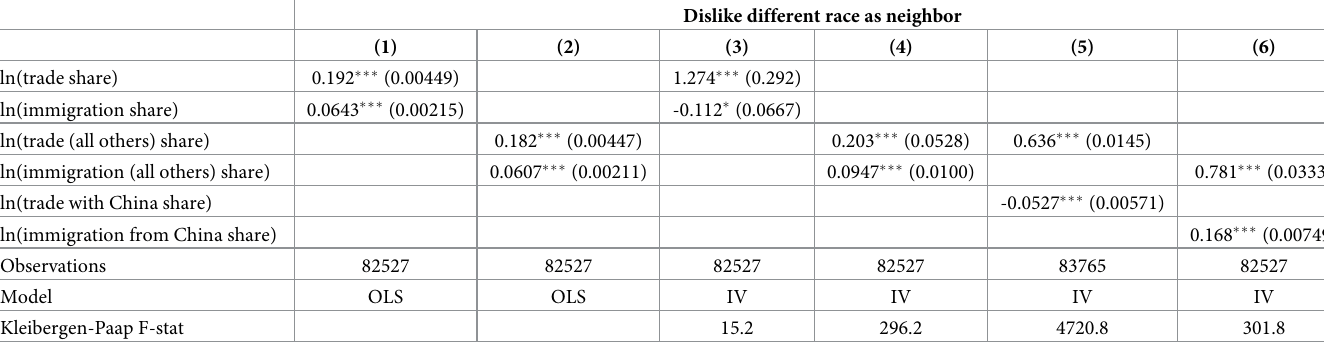
Table 9. Discrimination, openness to trade and immigration